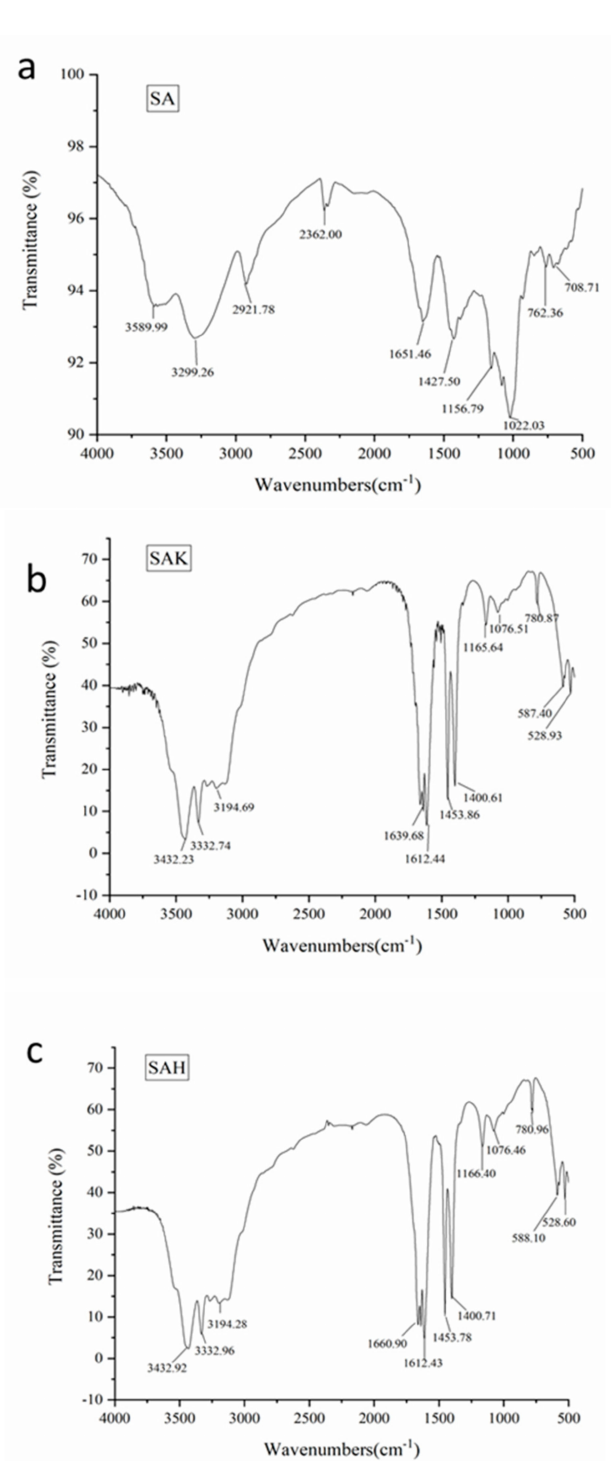
Figure1. FTIRspectraofstarch–alginatebasedbeads: ( a )starch-alginatebeads( b )starch-alginate-kaolin beads ( c ) starch-alginate-rice husk powder